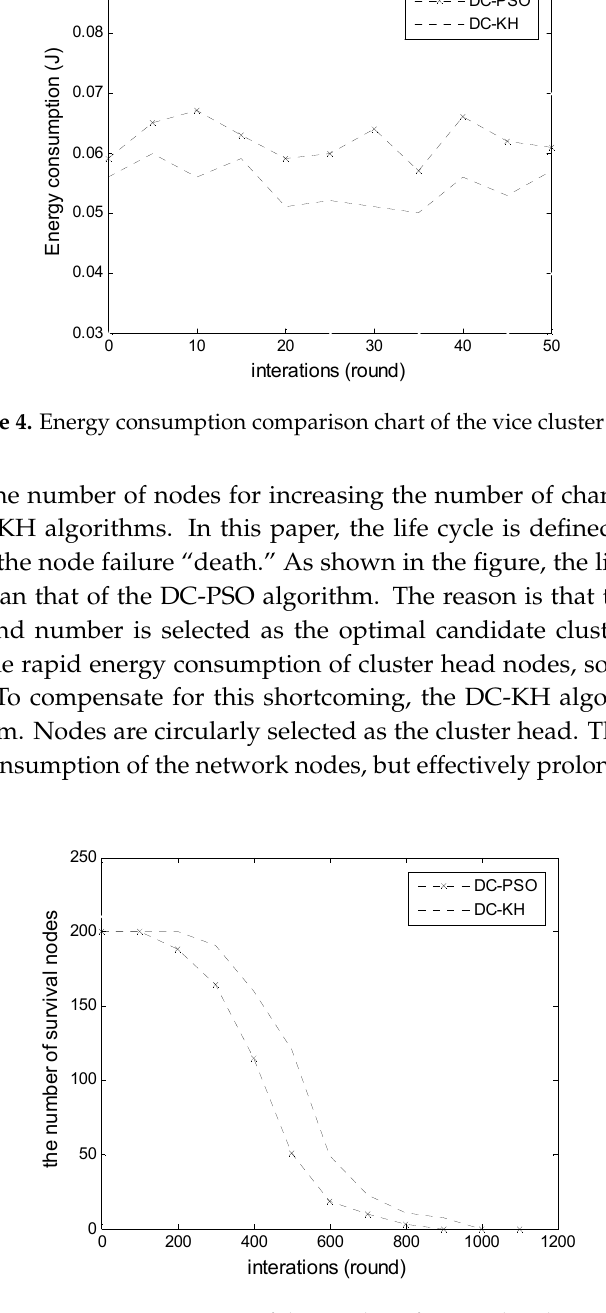
Figure 5. Comparison of the number of survival nodes.